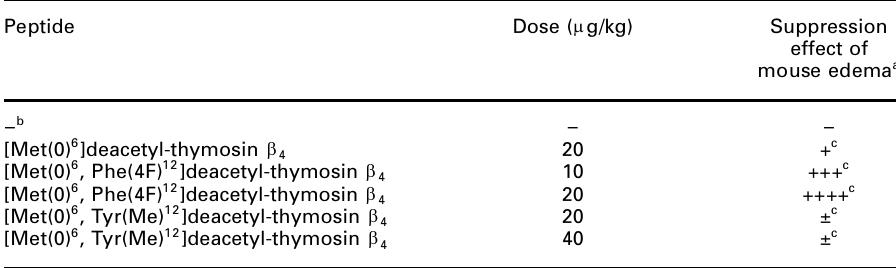
Table 3. Comparison of [Met(0) 6 ]deacetyl-thymosin b 4 , [Met(0) 6 , Phe(4F) 12 ]deacetyl-thymosin b 4 and [Met(0) 6 , Tyr(Me) 12 ]deacetyl-thymosin b 4 by in vivo assay on suppression of carrageenin- induced footpad swelling in the mouse paw Peptide Dose ( m